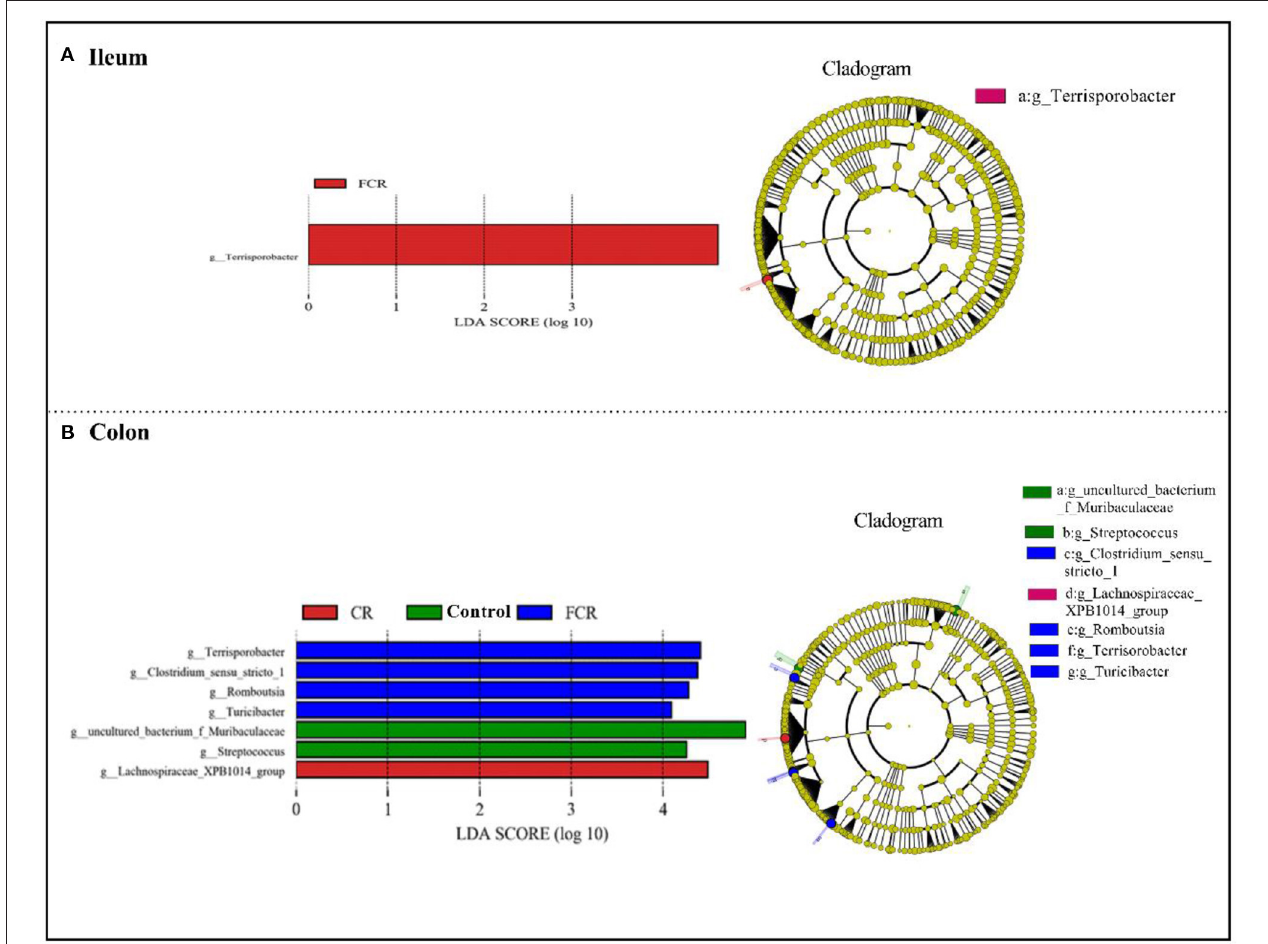
FIGURE 4 | Linear discriminant analysis combined effect size (LEfSe) measurement analysis of microbiota in the ileal (A) and colonic (B) contents of